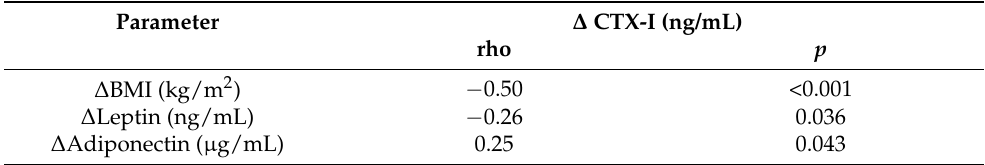
Table 6. Spearman rank correlation of the changes ( ∆ ) in C-terminal telopeptide of type I collagen (CTX-I) concentration and biochemical variables during a 3 months diet intervention ( n =